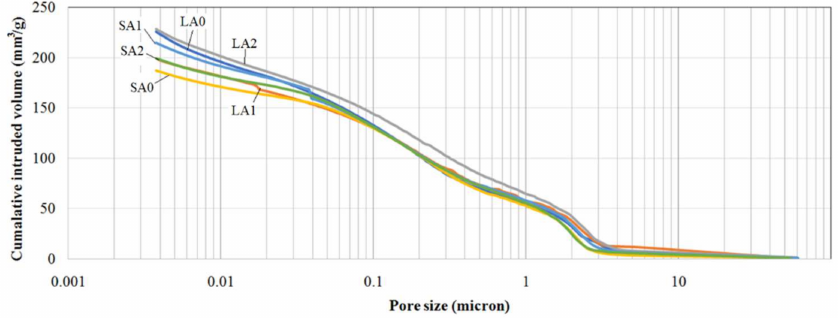
Figure 3. Pore size distribution of air lime mortars at 180 days of curing.